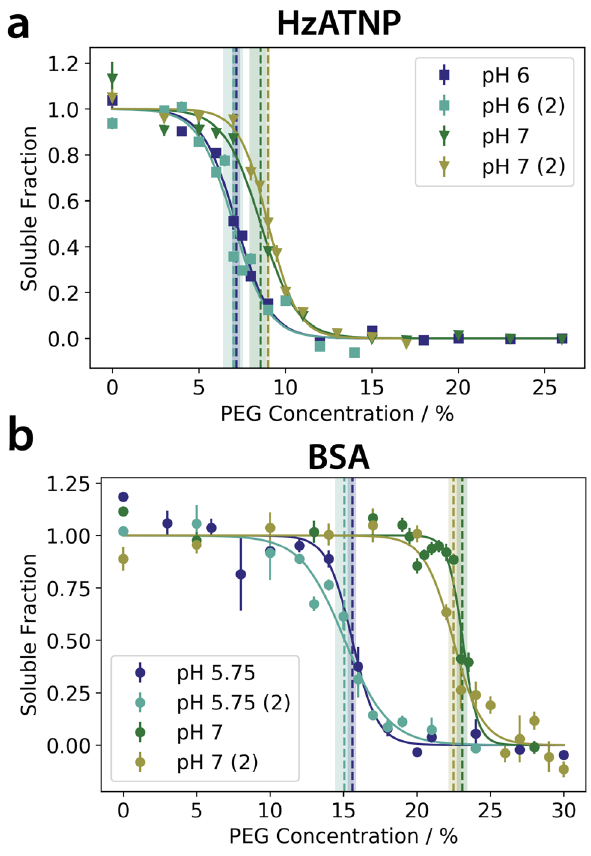
Figure 4. Accuracy and reproducibility of the automated PEG assay to measure the relative solubility of proteins at different pH values. The results of four independent measurements of the antibody HzATNP (a) and of BSA (b) at two different pH values highlight the accuracy and reproducibility of this assay. Vertical lines represent PEG 1/2 values including their 95% confidence intervals. The legend described the buffer pH and (2) denotes a second independent experiment carried out on a different day from a fresh sample